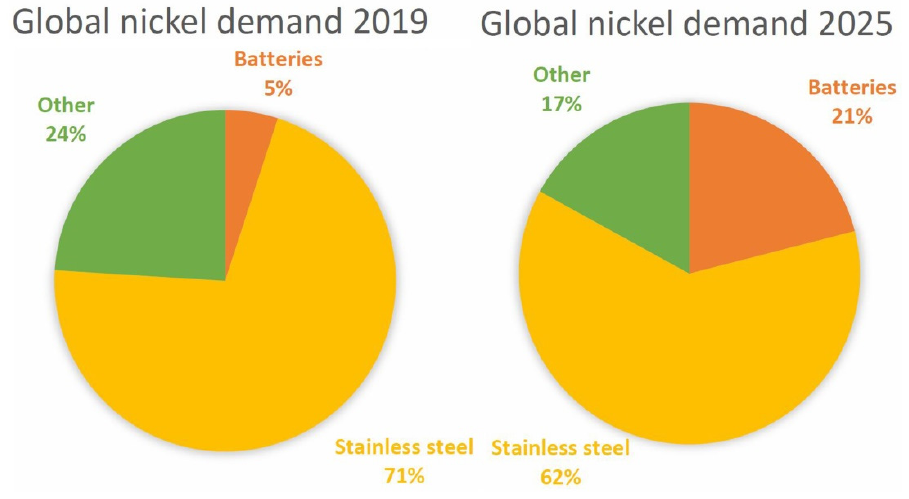
Figure 1. Nickel demand by application